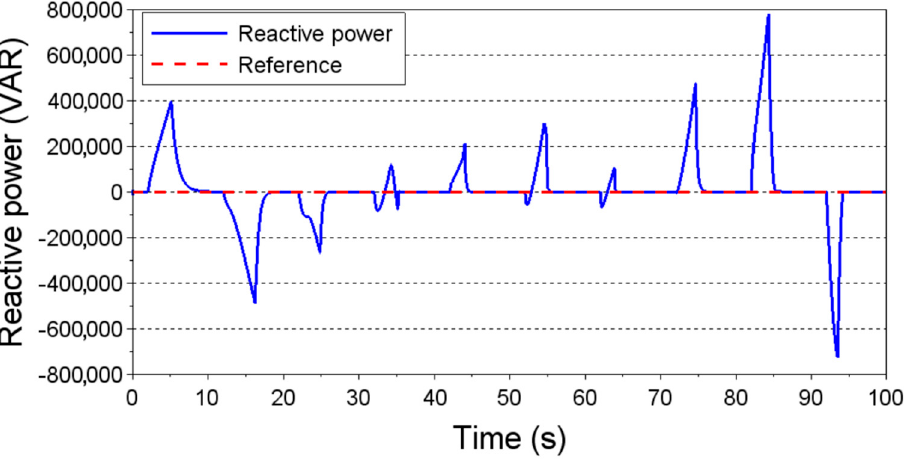
Figure 10. Reactive power.